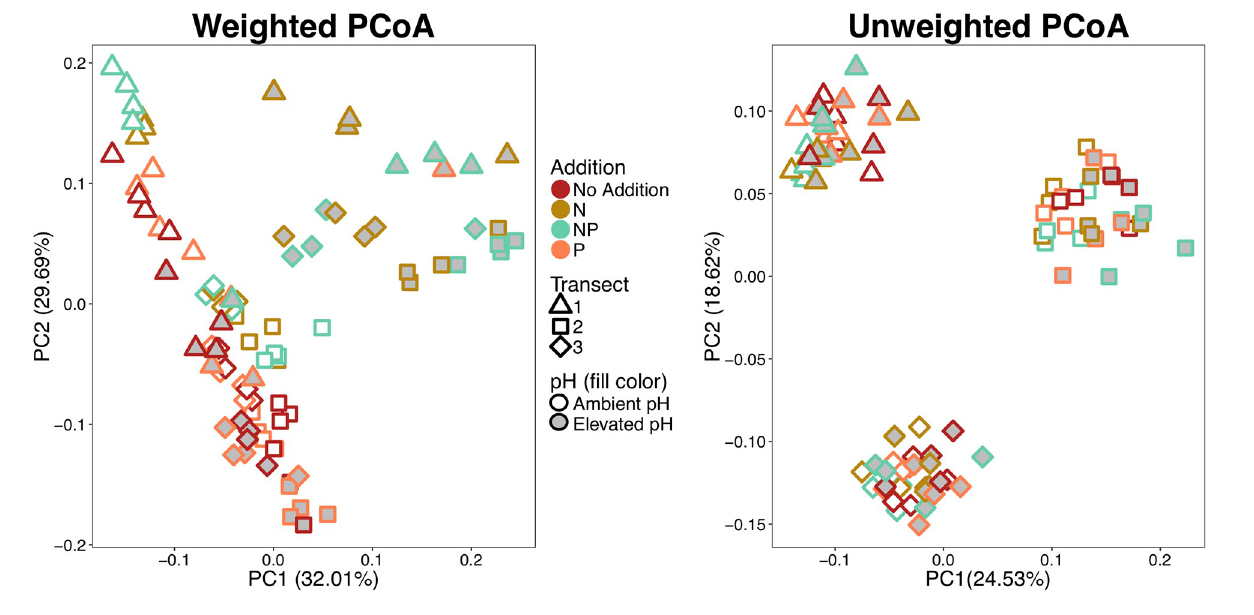
Fig 3. Weighted and unweighted UniFrac PCoA ordinations of microcosm microbial communities. Each point represents an individual microcosm. Color, shape, and fill are used to code for by nutrient addition, transect (origin location), and pH treatment, respectively. Ordinations include samples from both temperature treatments and time points (not denoted) as they did not significantly differ.